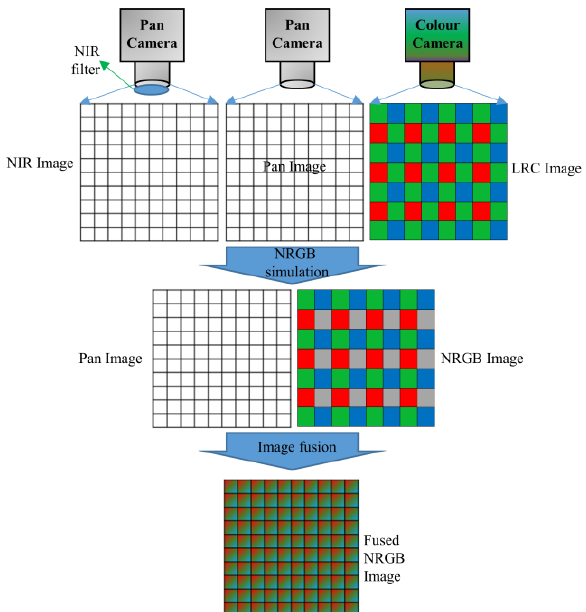
Figure 1: Configuration 1: A Pan image is fused with an LRC image to produce a fused RGB image in which the resolution is as high as the Pan image with the colour information inherited from the LRC image. To remove the unwanted NIR portion of the Pan image, an NIR-cut filter is used in front of the Pan camera.